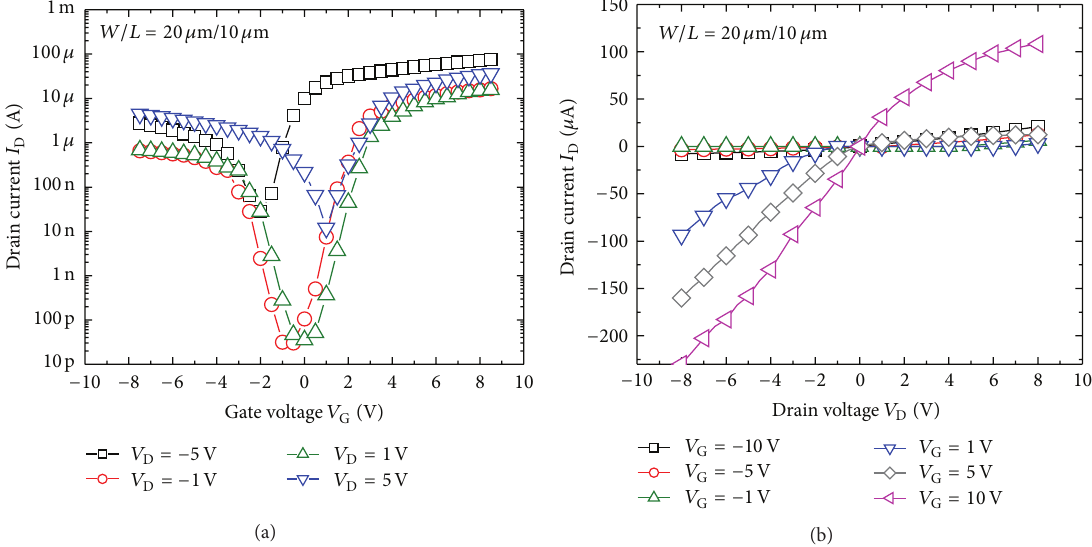
Figure 2: Current-voltage ( I-V ) characteristics of a 20 𝜇 m × 10 𝜇 m ambipolar nc-Si TFT with 20nm HfO 2 gate dielectric. (a) Transfer characteristics ( 𝐼 𝐷 − 𝑉 𝐺 ) in both forward (symbols) and reverse (lines) directions illustrating the low hysteresis in the device and (b) output characteristics ( 𝐼 𝐷 − 𝑉 𝐷